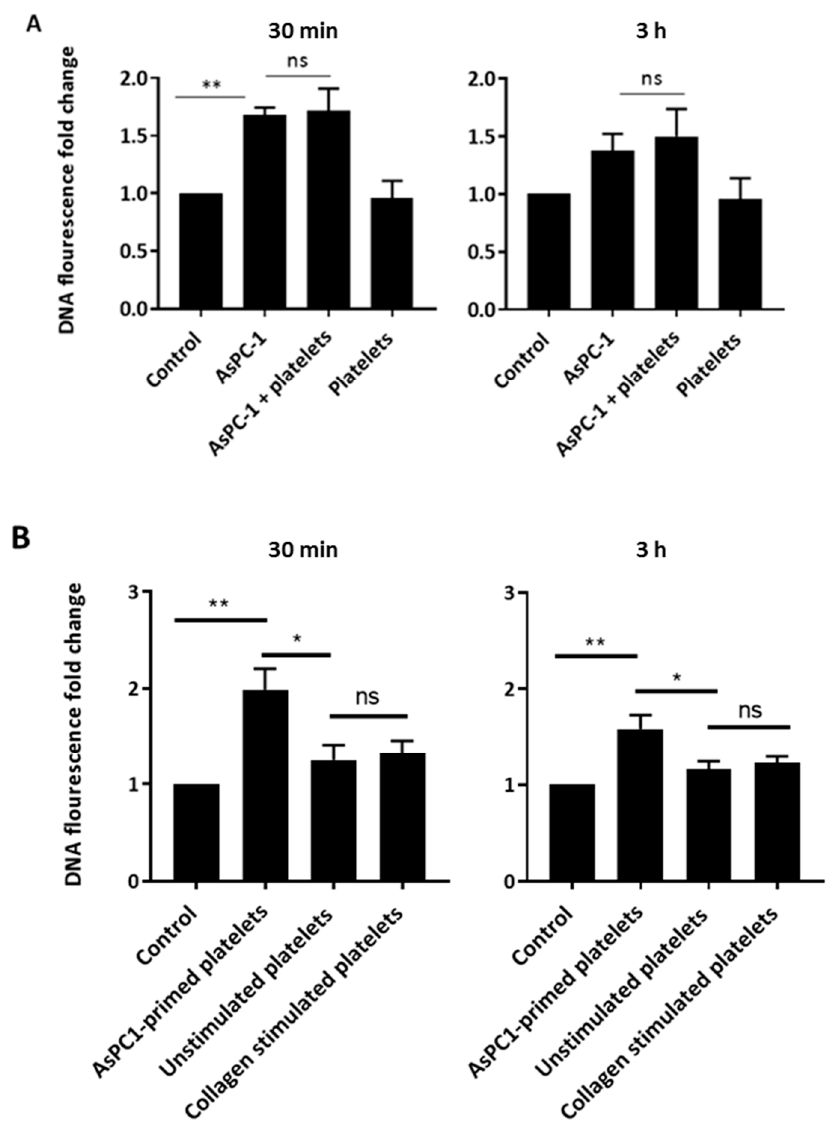
Figure 5. AsPC-1-primed platelets, but not washed platelets, stimulate rapid release of NETs. ( A ) Platelets (1 × 10 8 /mL) were incubated with neutrophils and AsPC-1 cells. Platelets had no effect on AsPC-1-induced NETS; ( B ) the effect of AsPC-1-primed platelets on NET release. Platelets were primed with AsPC-1 cells by incubation with AsPC-1 for 4 h. The supernatant was removed and centrifuged to pellet platelets which were then resuspended and incubated with neutrophils. Primed platelets caused rapid NET release in 30 min. ( n = 4, * p < 0.01, ** p < 0.001 and ns = non-significant. One-way ANOVA followed by Bonferroni post-hoc). Control: unstimulated neutrophils. Data expressed as mean ± SEM.